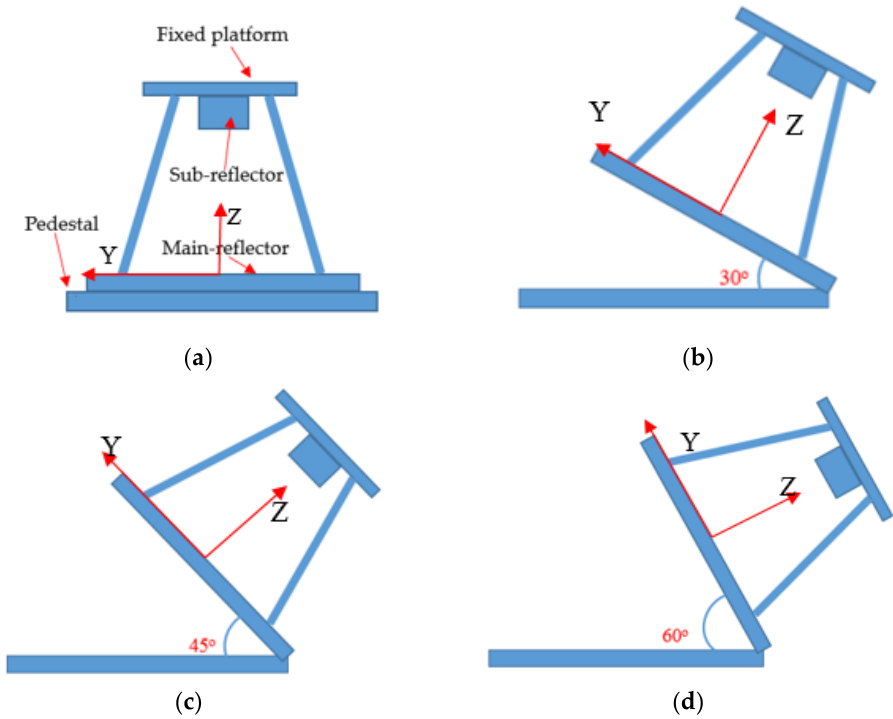
Figure 9. The side views of the supporting structure under different states: ( a ) Initial state; ( b ) Pitch